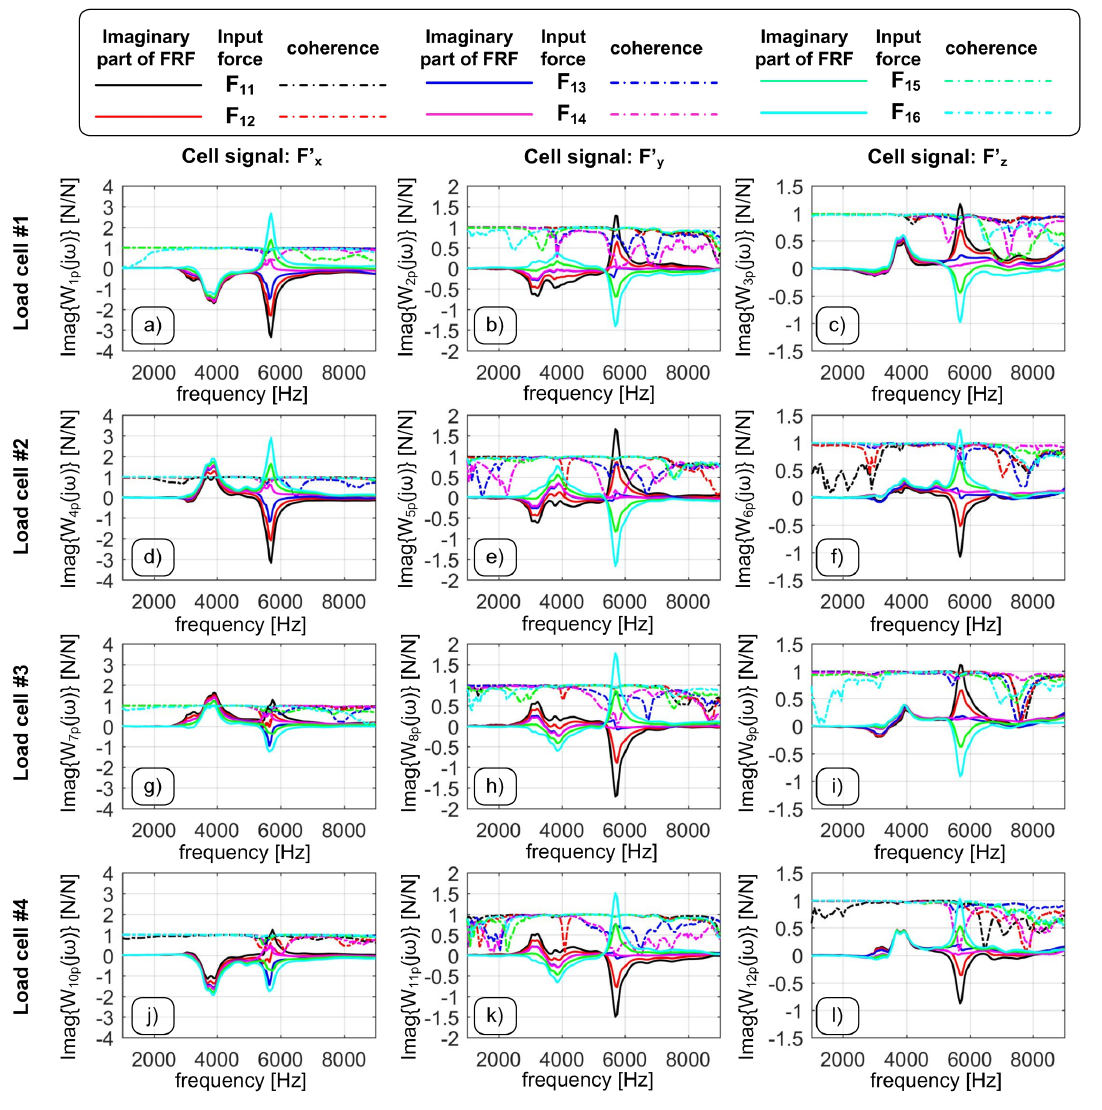
are the load cell signals in the k